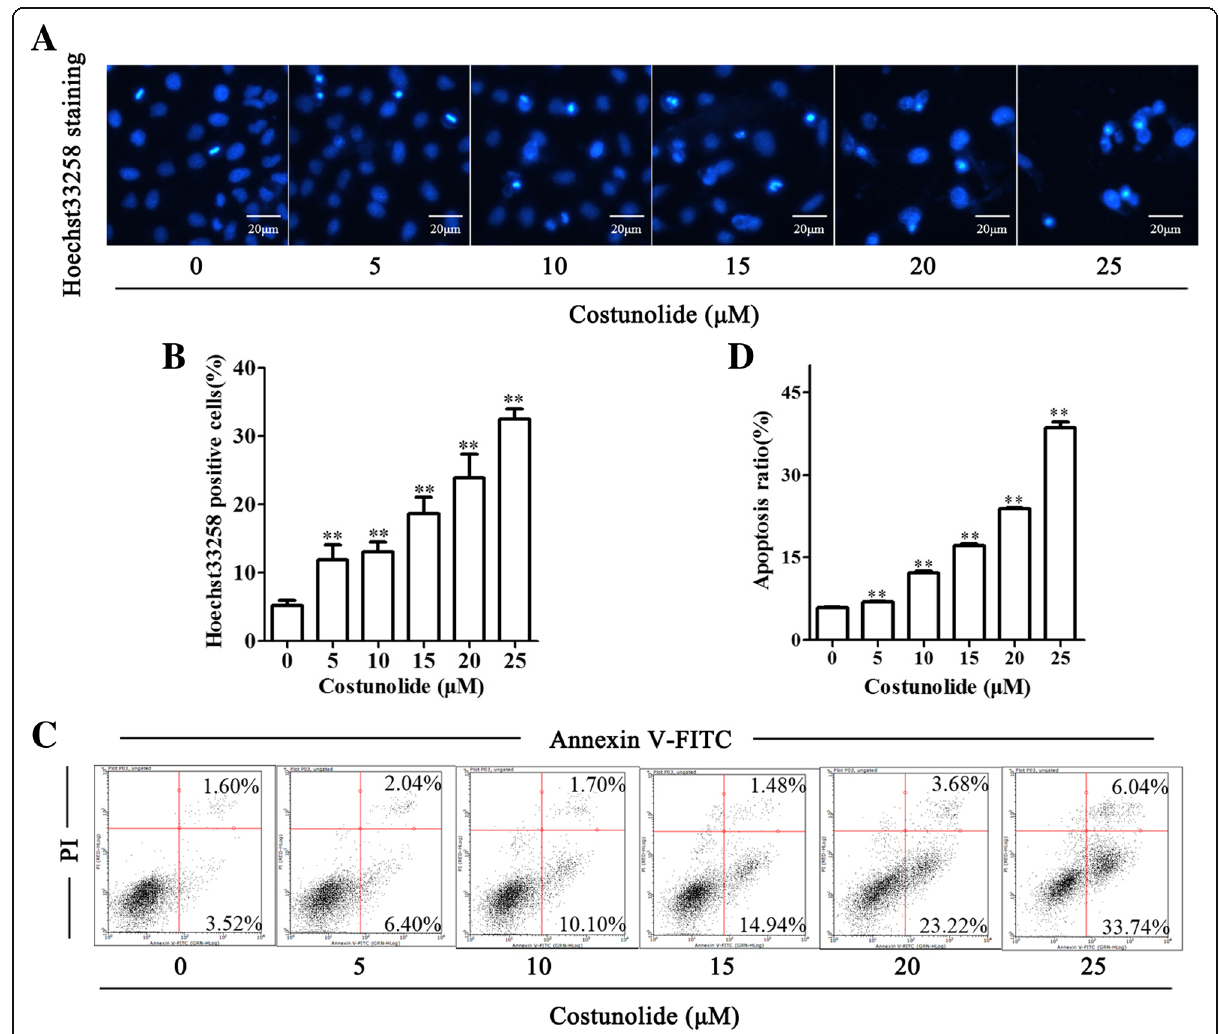
Fig. 2 Costunolide induced the apoptosis of gastric adenocarcinoma BGC-823 cells. a Hoechst33258 staining of BGC-823 cells treated by costunolide with different concentration (0, 5, 10, 15, 20 and 25 μ M) for 24 h are photographed by fluorescence microscope (magnification: 200×, bar in the pictures represents 20 μ m). b Statistical data of Hoechst33258 positive cells. c Apoptosis of BGC-823 cells treated by costunolide with different concentration (0, 5, 10, 15, 20 and 25 μ M) for 24 h and stained by Annexin V-FITC and PI is detected by flow cytometry. d Statistical data of BGC-823 cell apoptosis. Compared to control group, * P < 0.05, ** P <